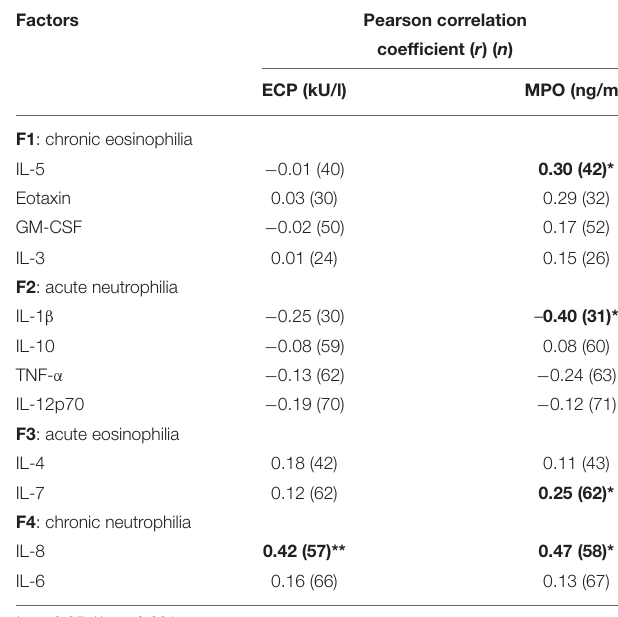
TABLE 4 | Correlation between log transformed serum inflammatory markers (ECP and MPO) and cytokine concentrations for the various factors identified in dental healthcare workers.